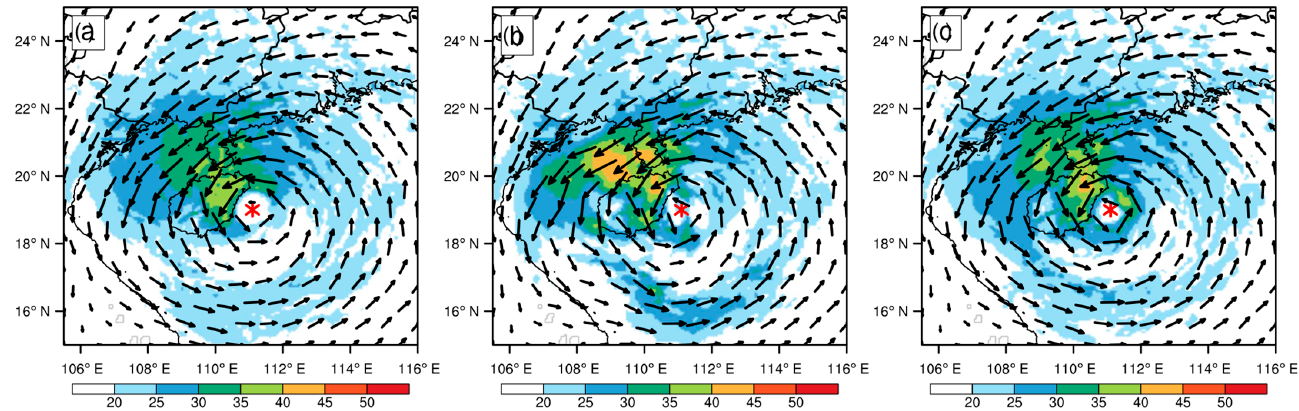
Figure 6. Wind speed with units as m s − 1 of ( a ) background and ( b ) DA_ ψχ ; ( c ) DA_UV) analysis and vector on 850 hPa at 0600 UTC 13 October. The center location of Kompasu from CMA is indicated (red asterisk).